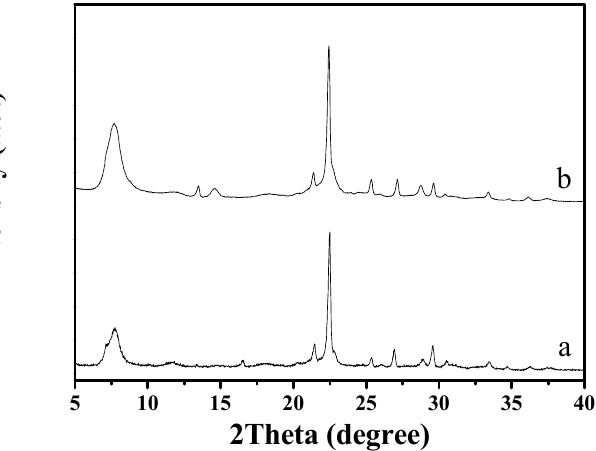
Figure 1. XRD patterns of ( a ) as-synthesized and ( b ) calcined S-Beta zeolite.